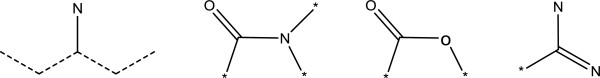
Patterns of atom C with the connection number of 3 (the dashed bond means that its order is unsure).